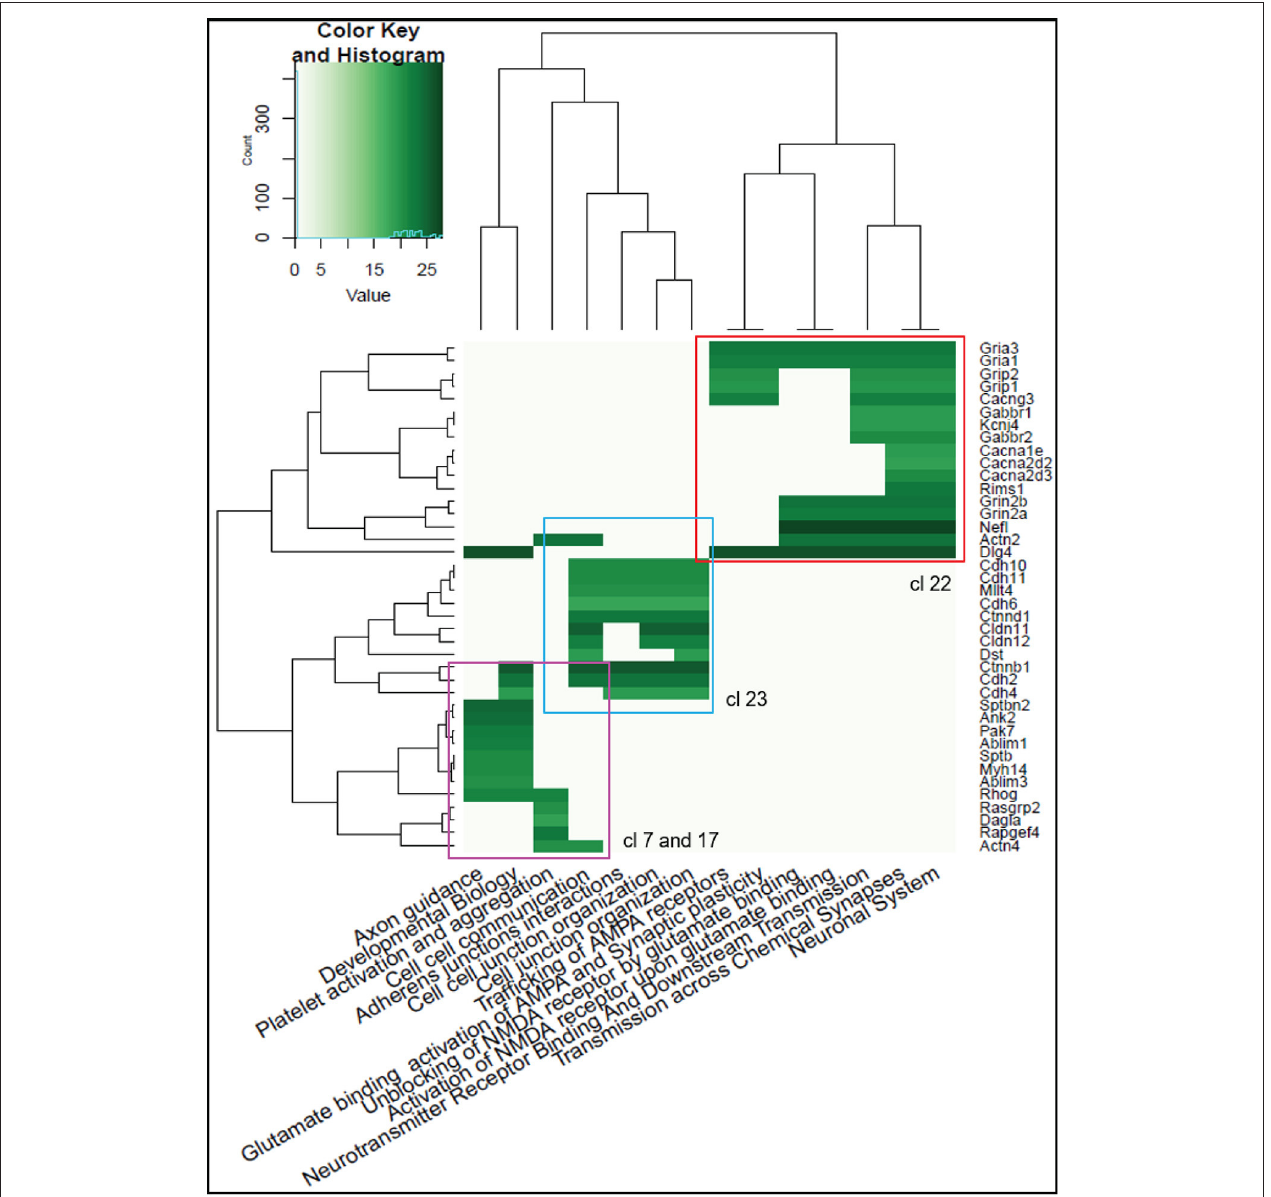
FIGURE 3 | Heatmap of the Reactome Pathway enrichment analysis clustering. Intensity is based on the average relative protein abundance in MS. Three main modules are observed: upper right, Module 1; center, Module 2; and, bottom left, Module 3.